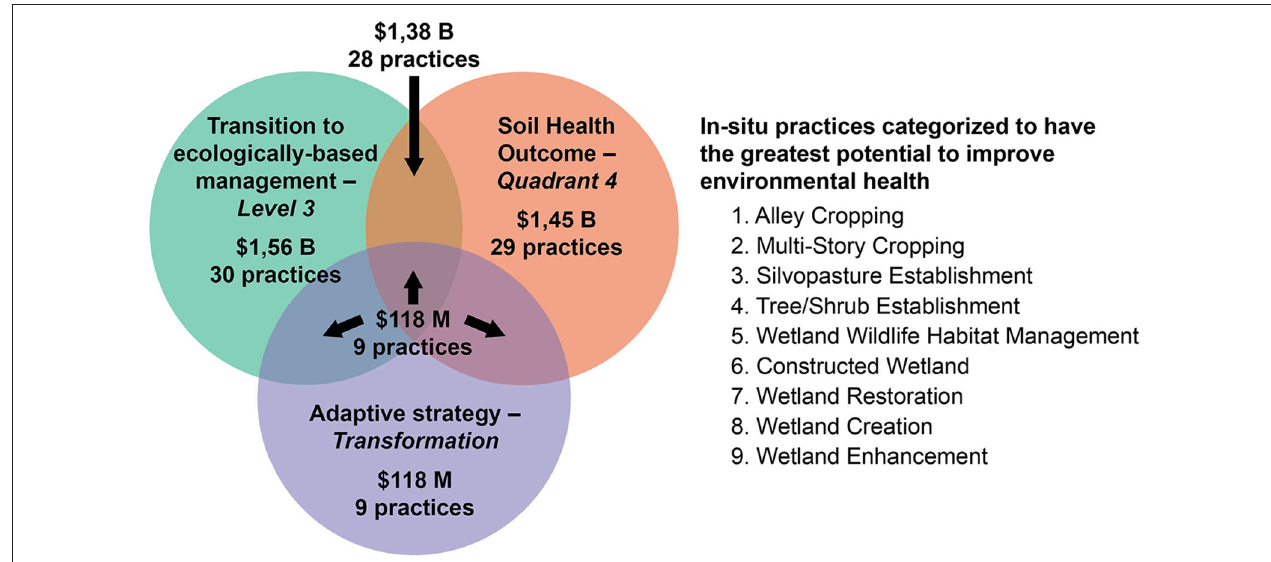
FIGURE 4 | Total invested dollars in the EQIP program from 2009 to 2018 in the classifications and categories having the greatest potential to improve soil health (green), transition to ecologically-based management (orange), and expand adaptive strategy (purple) that were also executed in-situ on managed lands. Overlapping practices meeting multiple top categories and invested dollars are identified in the Venn diagram. Our analysis identified nine overlapping in-situ practices on managed lands in the top categories for our